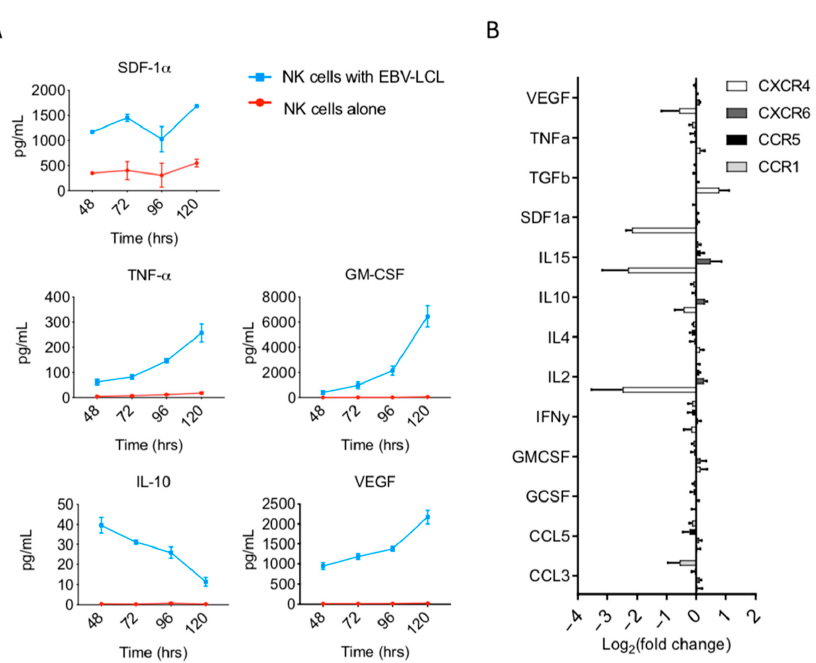
Figure 5. Ex vivo expansion of NK cells with EBV-LCL feeder cells creates a pro-inflammatory environment. ( A ) NK cell culture supernatants were analyzed using a multiplex assay for the presence of various cytokines and chemokines. Molecule concentrations are reported as pg/mL over time. Line graphs show data from supernatants collected from NK cell expansion with EBV-LCL feeder cells (blue) or from supernatants of NK cell alone in IL-2-containing media (red) ( n = 2 technical replicates, 2 biological replicates). ( B ) Surface expression changes of chemotactic receptors in response to exposure to individual various cytokines and chemokines for 24 h in vitro ( n = 3). PBMCs in NK media with various cytokines in vitro for 24 h. We observed that VEGF, TNF- α , IL10, IL4, IFN- γ , GM-CSF, GCSF, CCL5, and CCL3 had no direct effect on the surface expression of CXCR4, CXCR6, CCR5, or CCR1 (Figure 5B). In contrast, there was a slight increase in CXCR4 expression 24 h after NK cells were exposed to TGF- β , and a substantial decrease in CXCR4 expression 24 h after NK cells were exposed to SDF1a, IL-